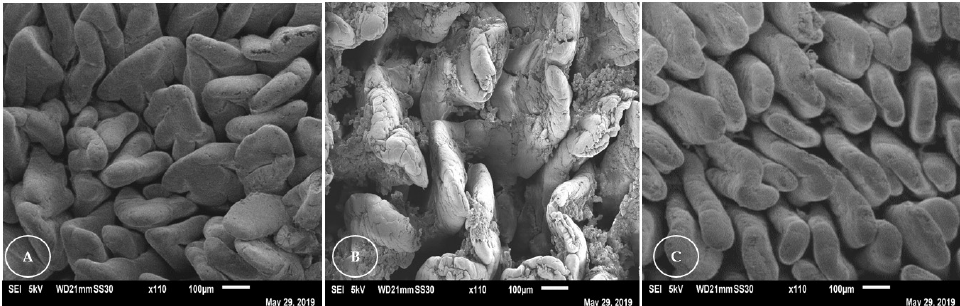
Figure 2. Ultrastructural analysis of the duodenum of rabbits that were fed three experimental diets: ( A ) Control, ( B ) Nanosoy, and ( C ) Nanopupunha.